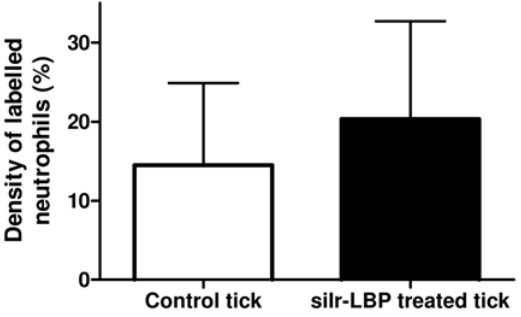
Figure 9. Density measurement of labeled neutrophils in skin of tick-infested mice. The light histogram represents the percentage of neutrophils per zone in skin sections of mice infested with control ticks (n=55). The dark histogram represents the percentage of neutrophils per zone in skin sections of mice infested with ticks treated with Ir-LBP siRNA (n=35, **: p , 0.05).